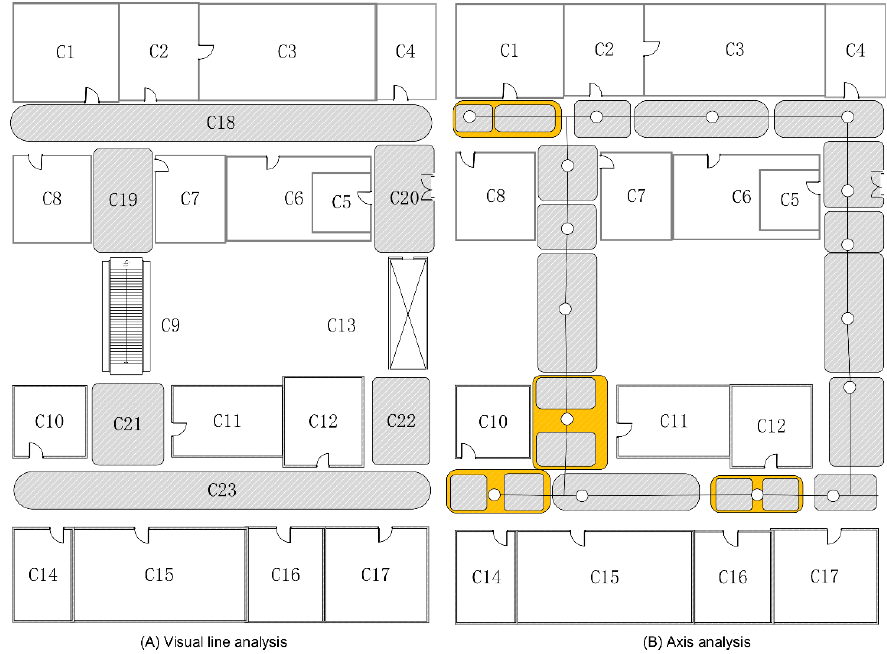
Figure 8. ( A,B ) Visual line analysis and axis analysis.